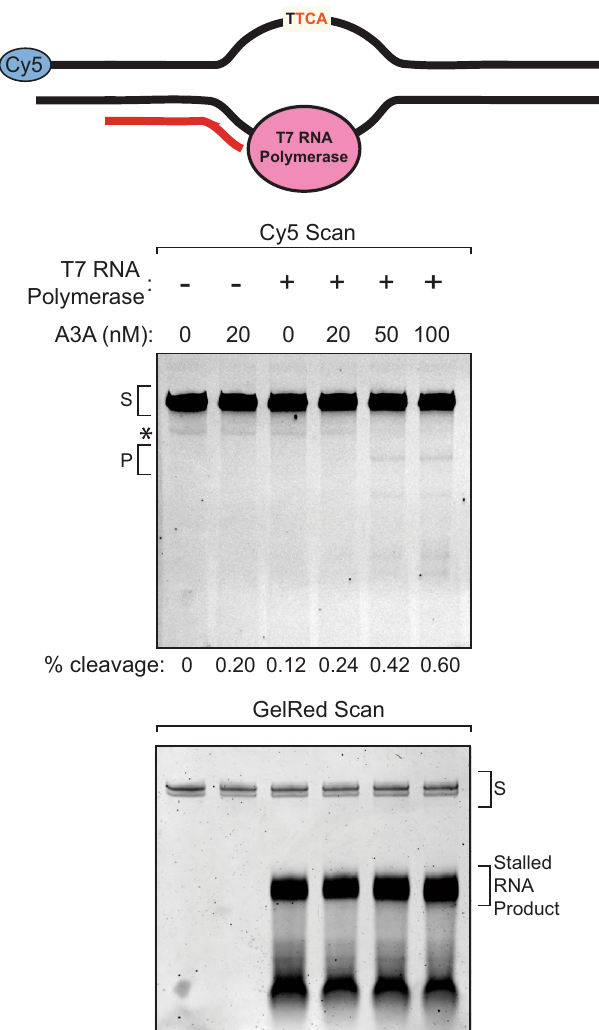
Figure 5. APOBEC3A activity is low on transcription bubbles. Deaminase assay of 0, 20, 50, or 100 nM A3A during in vitro T7 RNA polymerase transcription, stalled at T in AAGT within the transcribed strand (i.e. across from a TTCA on the non-transcribed strand). Reactions were carried out with 50 units of T7 RNA polymerase or an equal volume of 50% glycerol, and GTP, CTP, and UTP but no ATP, to cause the stalling. Reactions were incubated for 24 h at 37 °C in the presence of Uracil DNA Glycosylase, stopped by the addition of Proteinase K and SDS buffer, then heated for 10 min at 95 °C in formamide buffer before separating out product from substrate via denaturing polyacrylamide gels. Gels were imaged for Cy5 fluorescent tags (upper panel) and after staining with GelRed to observed total nucleic acids produced in the reaction (lower panel). S denotes the substrate band; P denotes the product band. Full-length gel images are presented in Fig. S8. Shown is a representative image from 10 independent